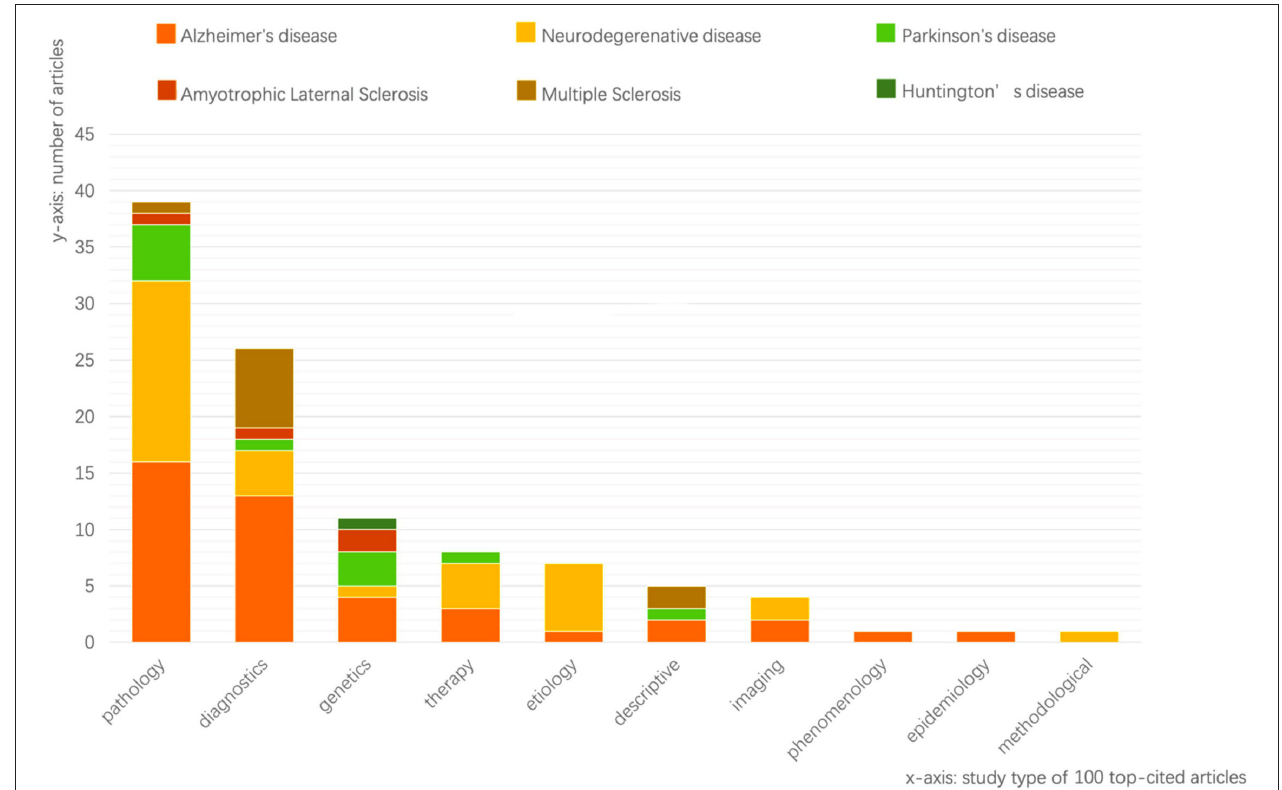
FIGURE 4 | Statistics of the study topic and type of the 100 top-cited